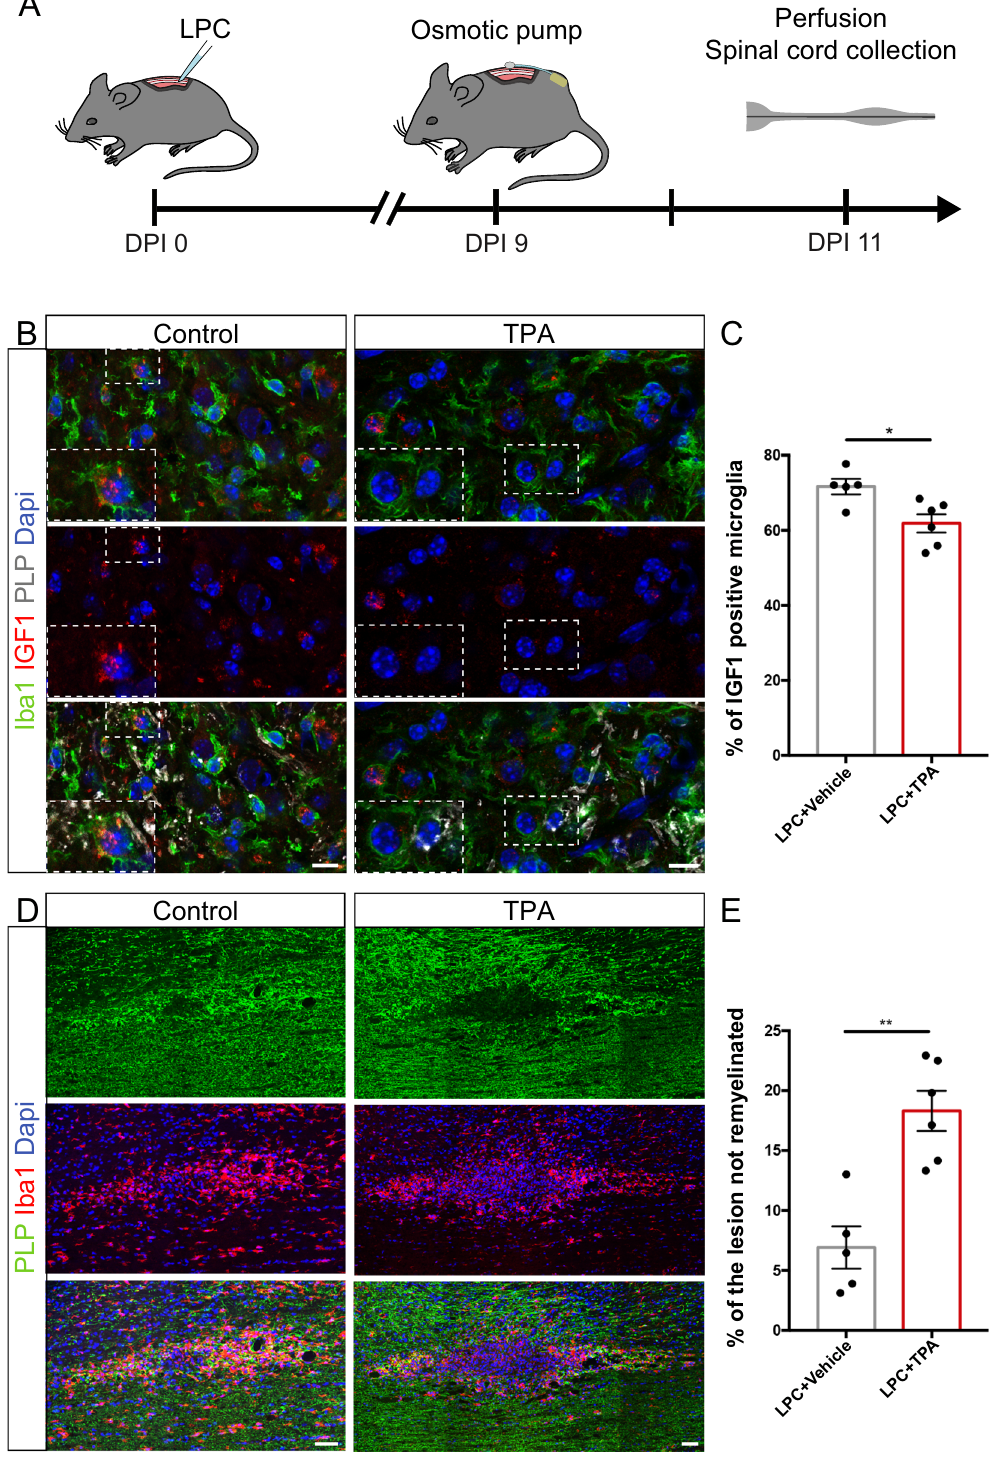
Fig. 8 Altered K + fl ux read-out by microglia following demyelination leads to a reduced number of pro-regenerative microglia and impairs remyelination in vivo. A Osmotic pumps were placed 9 days post LPC-injection to deliver NaCl 9 ‰ (Ctrl) or 50 μ M TPA at the lesion site and the spinal cords were collected 2 days later. B In remyelinating dorsal spinal cord lesion, the number of microglial cells expressing IGF1 is decreased following TPA treatment. C Percentage of IGF1 + microglial cells at 11 DPI in the remyelinating lesion, in control (Ctrl) or TPA condition ( B – C , Ctrl: n = 5 animals, TPA: n = 6 animals). D Remyelination is reduced following TPA delivery at the lesion. E Percentage of the lesion devoided of myelin at 11 DPI, in control or TPA condition ( D – E , Ctrl: n = 5 animals, TPA: n = 6 animals). Scale bars: B 10 μ m, D 50 μ m. C , E Two-sided Mann – Whitney tests. * P < 0.05, ** P <